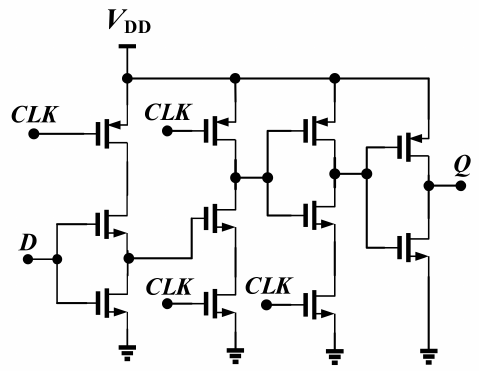
Figure 5. Schematic diagram of a TSPC DFF (DFF1) for an asynchronous